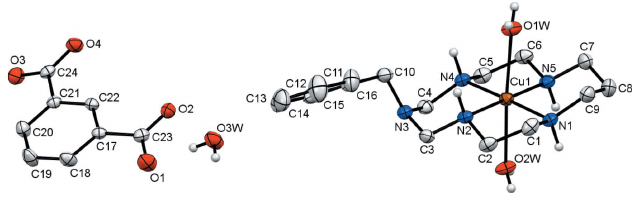
Figure 1 View of the asymmetric unit of (I), showing the atom-labelling scheme, with displacement ellipsoids drawn at the 30% probability level. H atoms attached to carbon atoms have been omitted for